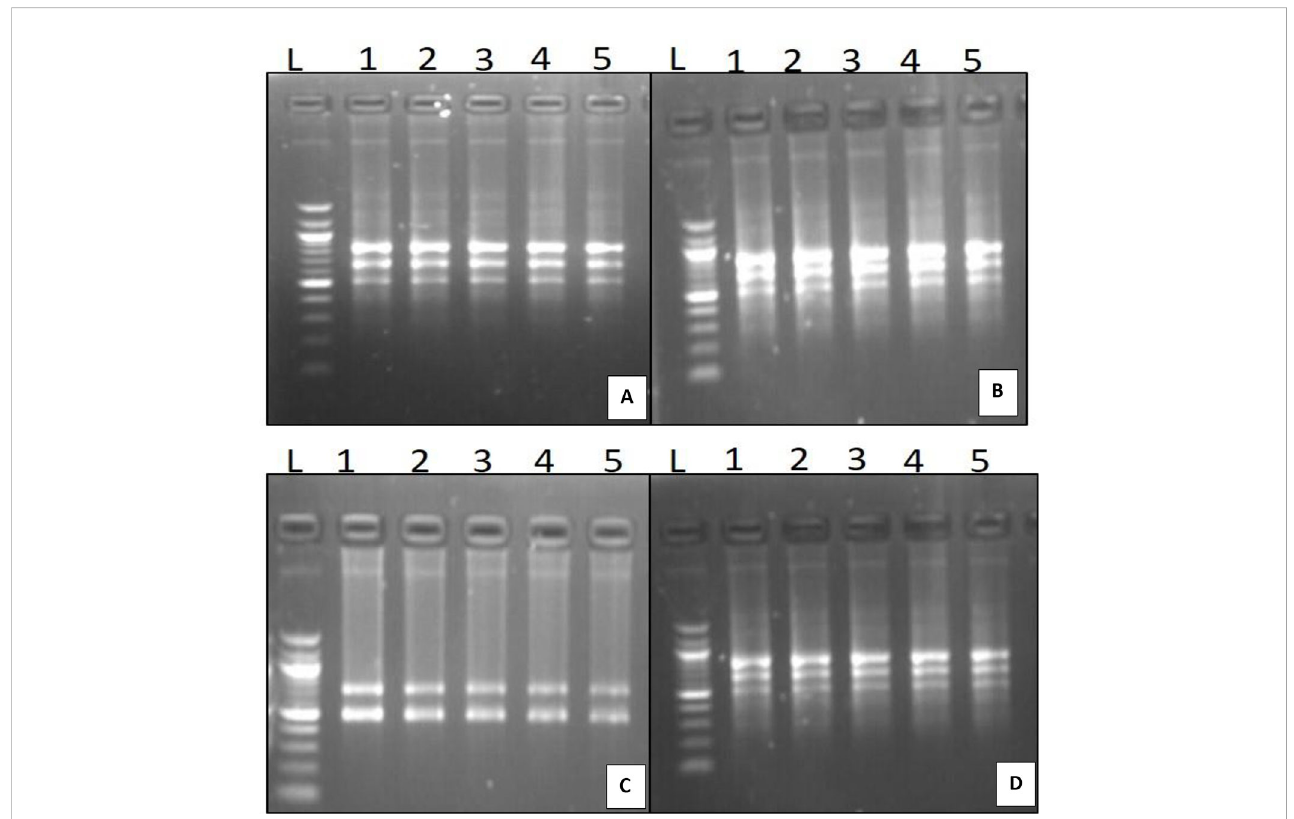
FIGURE 4 Genetic fi delity analysis of in-vitro and mother of D.transparens using ISSR marker (A) UBC 826 Primer L- Lader, 1 to 4 in-vitro plants; 5 mother plant; (B) UBC 834 Primer L- Lader, 1 to 4 in-vitro plants; 5 mother plant. (C) UBC 844 Primer L- Lader, 1 to 4 in-vitro plants, 5 mother plant, (D) UBC 880 Primer L- Lader, 1 to 4 in-vitro plants 4, 5mother plant; (Size of ladder- 1000 bp).